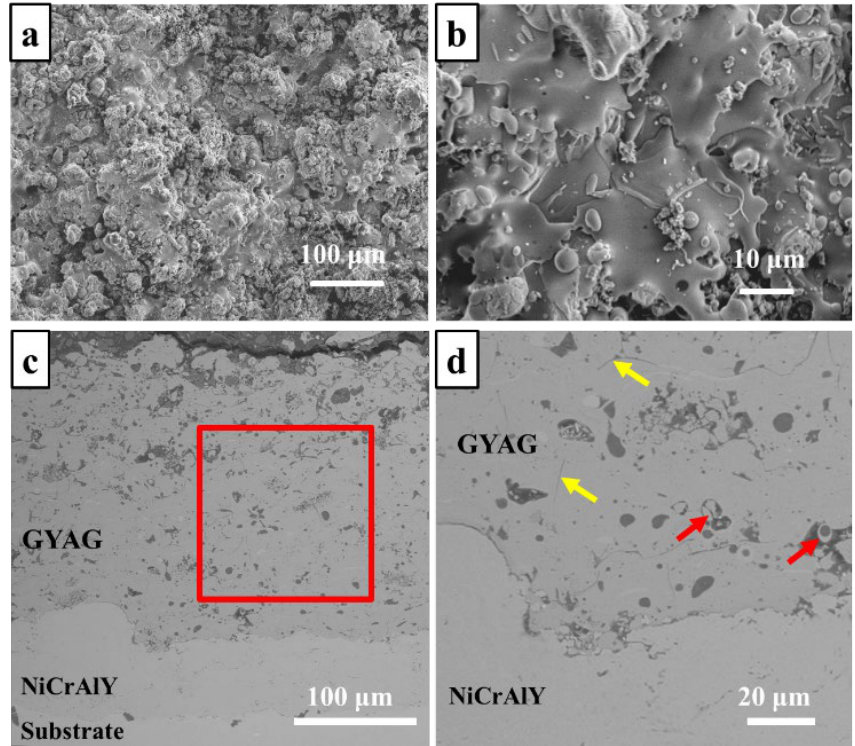
Figure 3. Surface ( a , b ) and cross-section ( c , d ) SEM images of plasma-sprayed GYAG coating, the porosities and cracks are highlighted by yellow and red arrows, respectively.